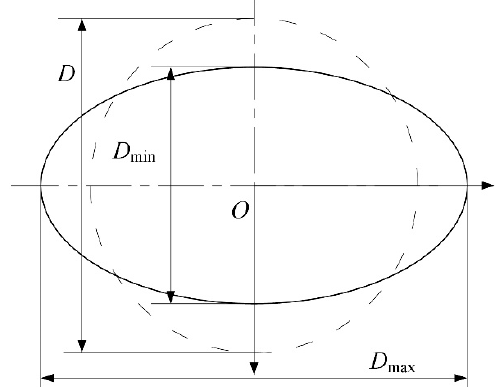
Figure 2. Definition of ovalization.